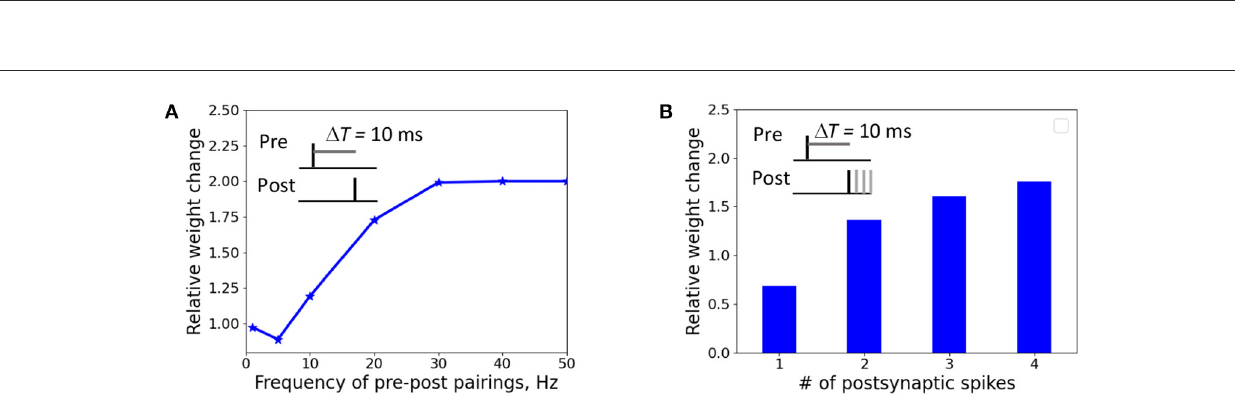
FIGURE4 Weight change dependence on frequency of postsynaptic pairings (A) and a number of postsynaptic spikes (B) . (A) A presynaptic action potential was paired with a single postsynaptic action potential 20 times at 1 T = 10 ms. (A) A presynaptic action potential was paired with a one to four postsynaptic action potentials 30 times at 5 Hz at 1 T = 10